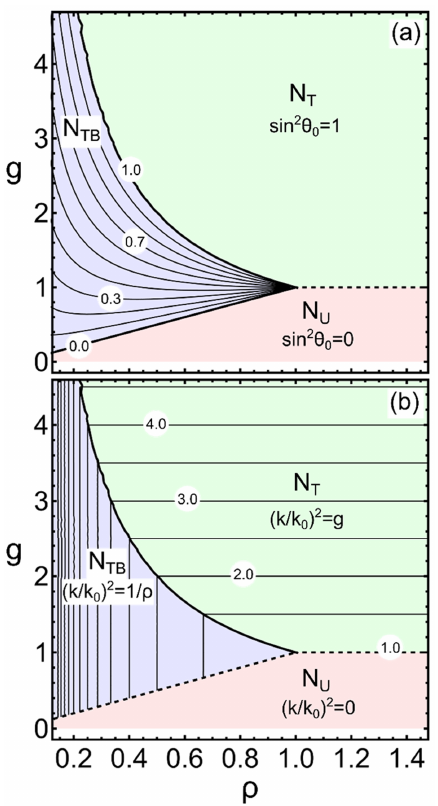
( ) = *2 (cid:1) (cid:0) = C ∗ 2 /2 AK 22 and 22 /2 g C AK and ( )